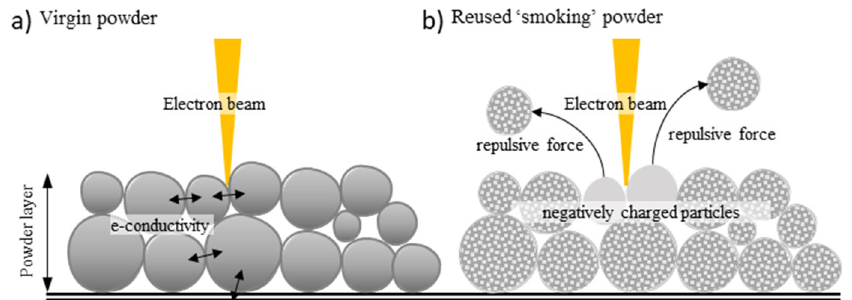
Figure 9. Schematic of powder deposition and interaction between particles of virgin ( a ) and reused ( b ) powder in